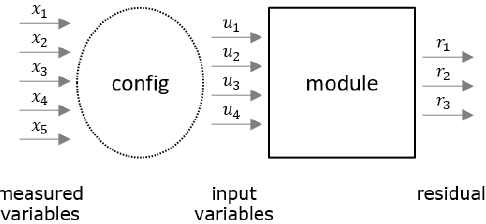
Figure 2. Concept of a component-specific system